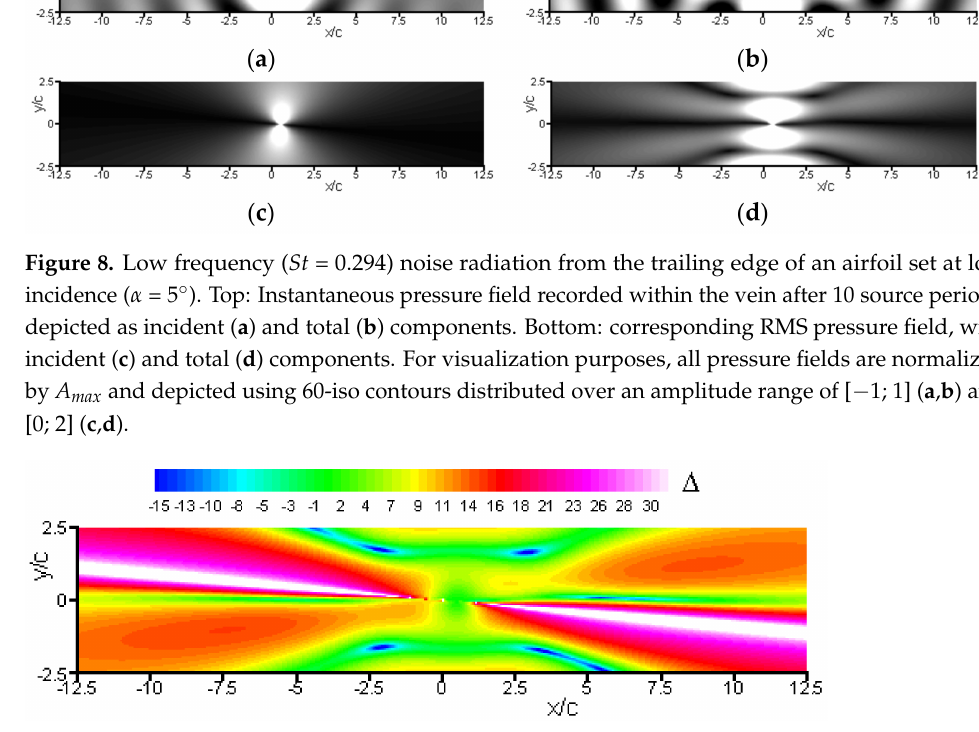
Figure 9. Low frequency ( St = 0.294) noise radiation from the trailing edge of an airfoil set at low incidence ( α = 5 ◦ ). Deltas (in dB) between the incident and total RMS pressure